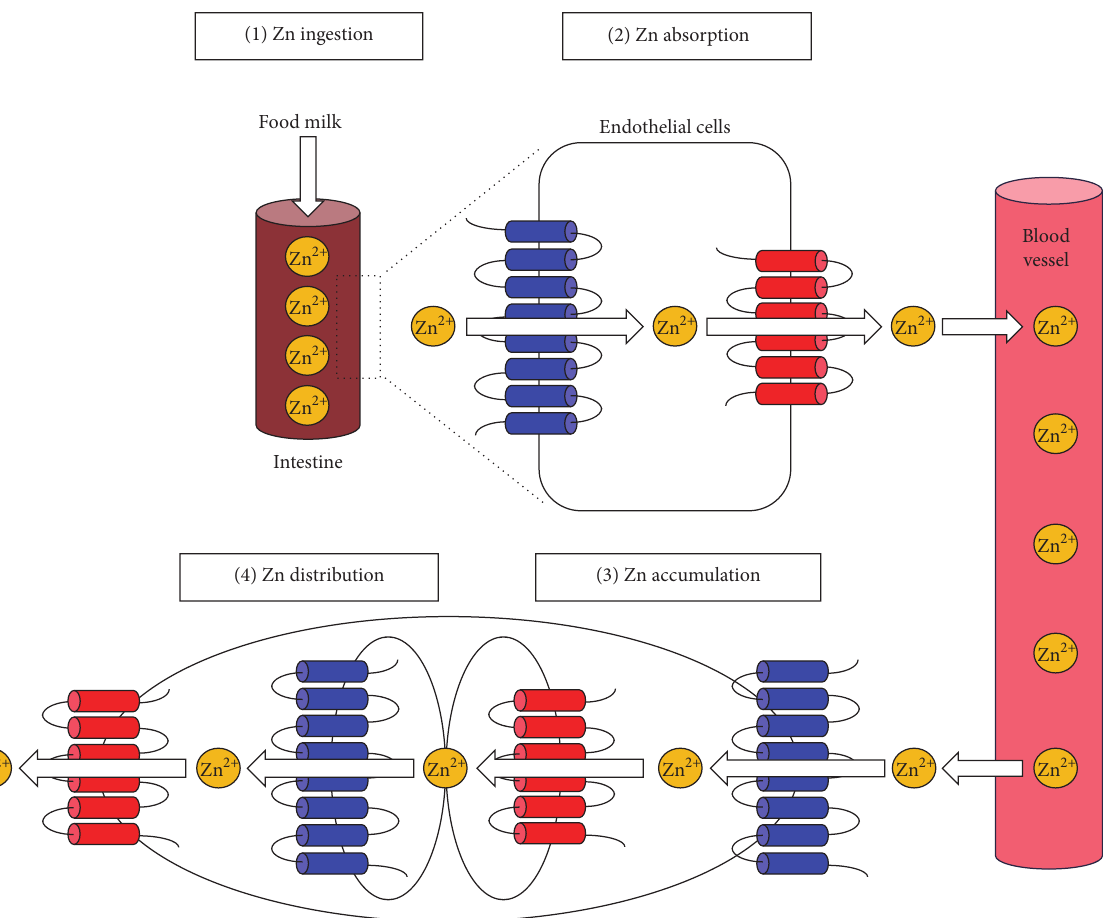
Figure 1: Zn transporters control Zn homeostasis. (1) Zn is ingested from the diet (or from breast milk in infants). (2) Zn is absorbed by intestinal Zn transporters and is released into the bloodstream. (3) Zn is taken up into peripheral cells by Zn transporters located on the plasma membrane. (4) Zn is distributed within the cell by intracellular Zn transporters. Each step is important for maintaining intracellular Zn levels. Disrupting Zn uptake results in ZnD and subsequent pathogenesis. ZIP (blue) and ZnT (red) transporters are